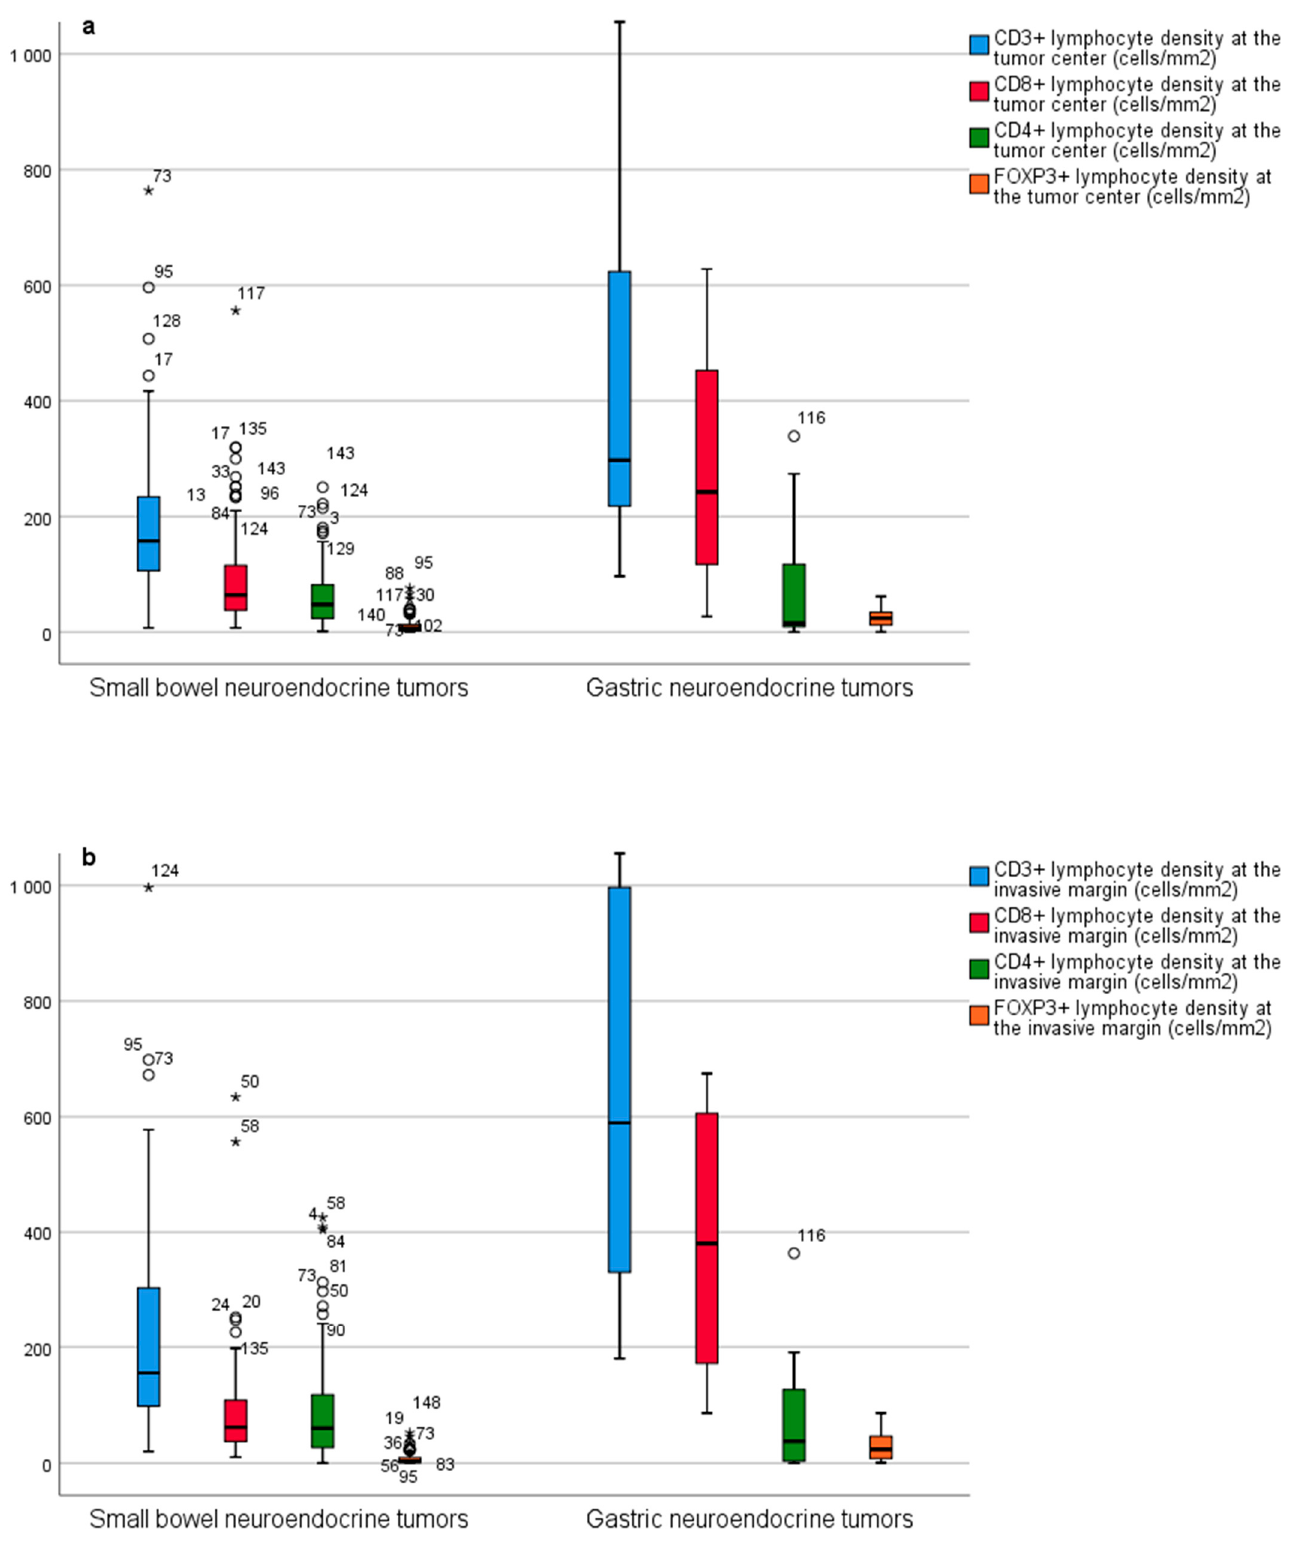
Figure 4. ( a ) Comparison of CD3 + , CD8 + , CD4 + and FOXP3 + immune cell densities between primary small bowel neuroendocrine tumors and primary gastric neuroendocrine tumors at the tumor center and ( b ) at the invasive margin. Outliers are marked with asterisks